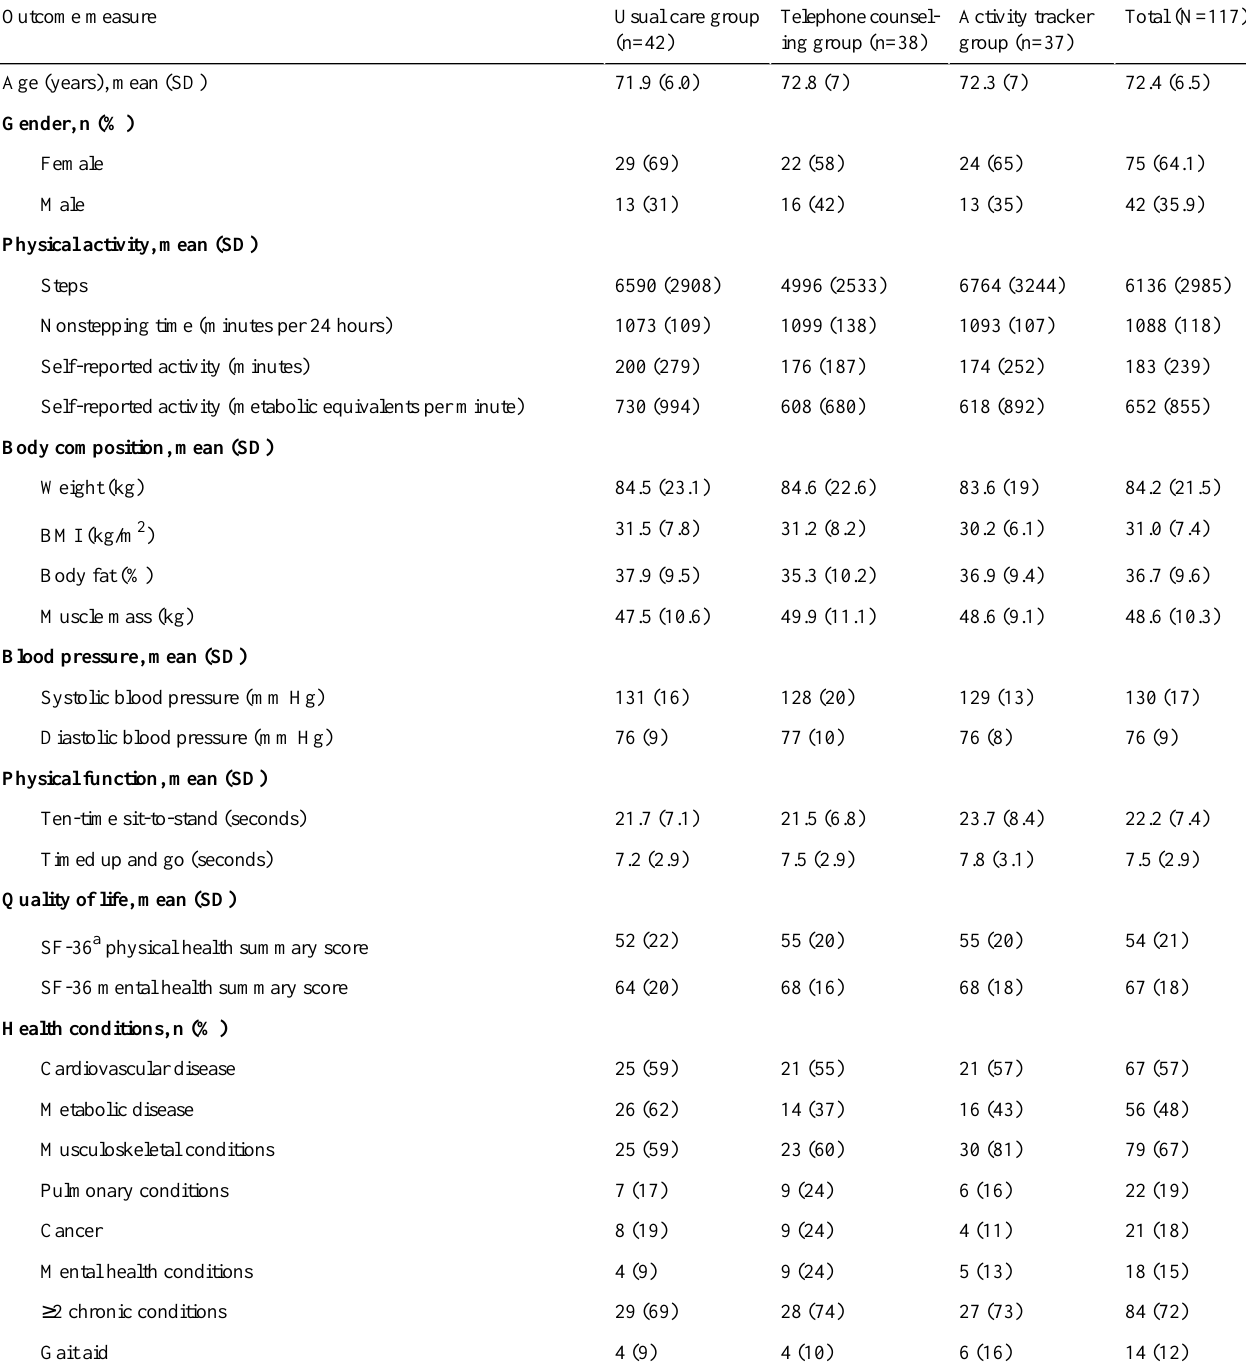
Table 1. Baseline (end of the Strength2Strength program) characteristics of randomized participants.